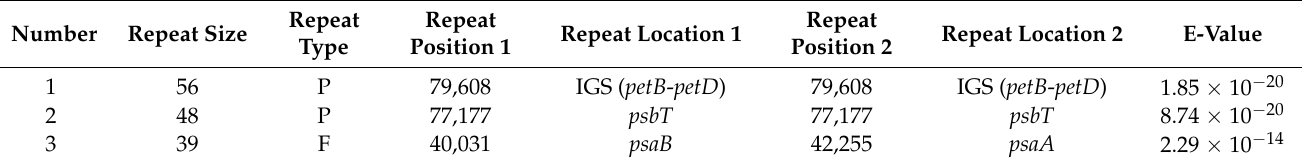
Table 5. Repeat sequences present in the P. angulata var. villosa plastome.